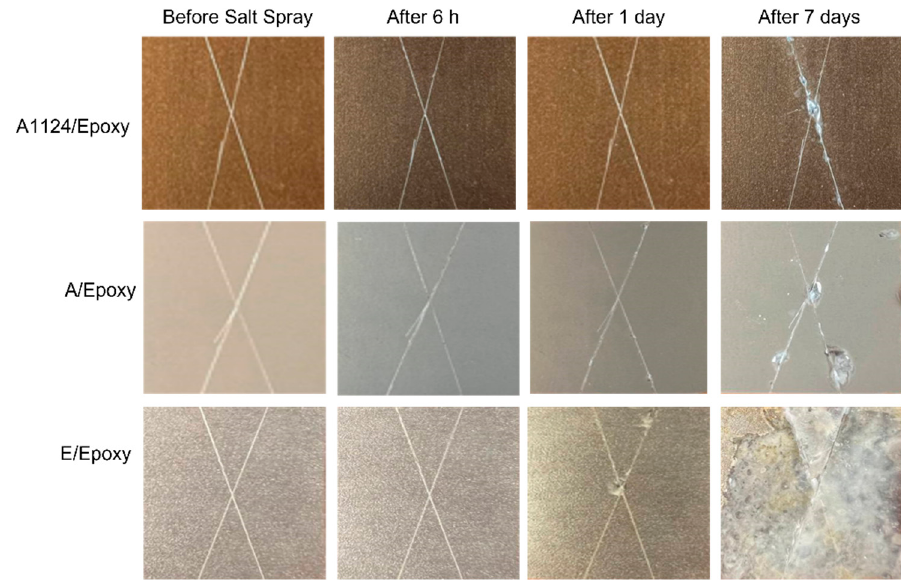
Figure 16. Macroscopic images of the x-cut samples after salt spray test.